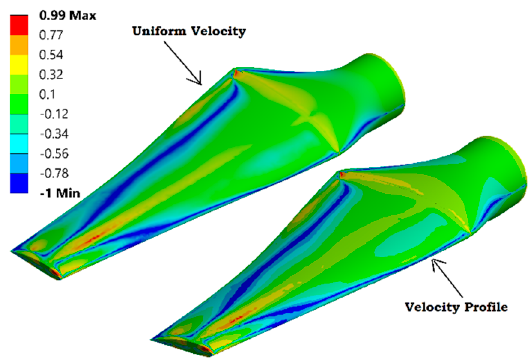
Figure 16. Biaxiality indication for the blade in uniform velocity and velocity profiles.